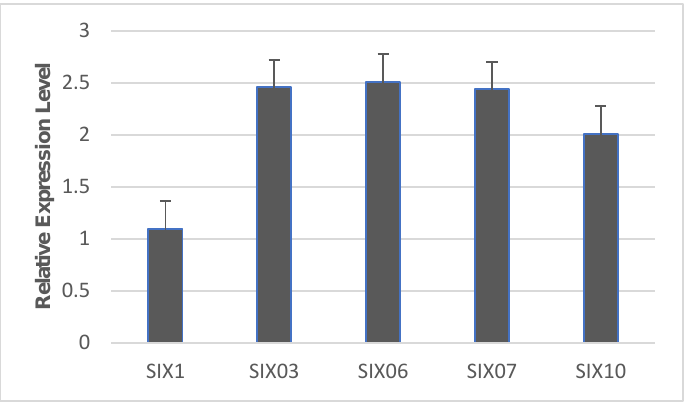
Figure 1. Expression profiling of Secreted in Xylem (SiX) genes in datepalm under F. oxysporum stress. The pathogen cultures of spores treated with 1500 µ g mL − 1 , 2000 µ g mL − 1 ,